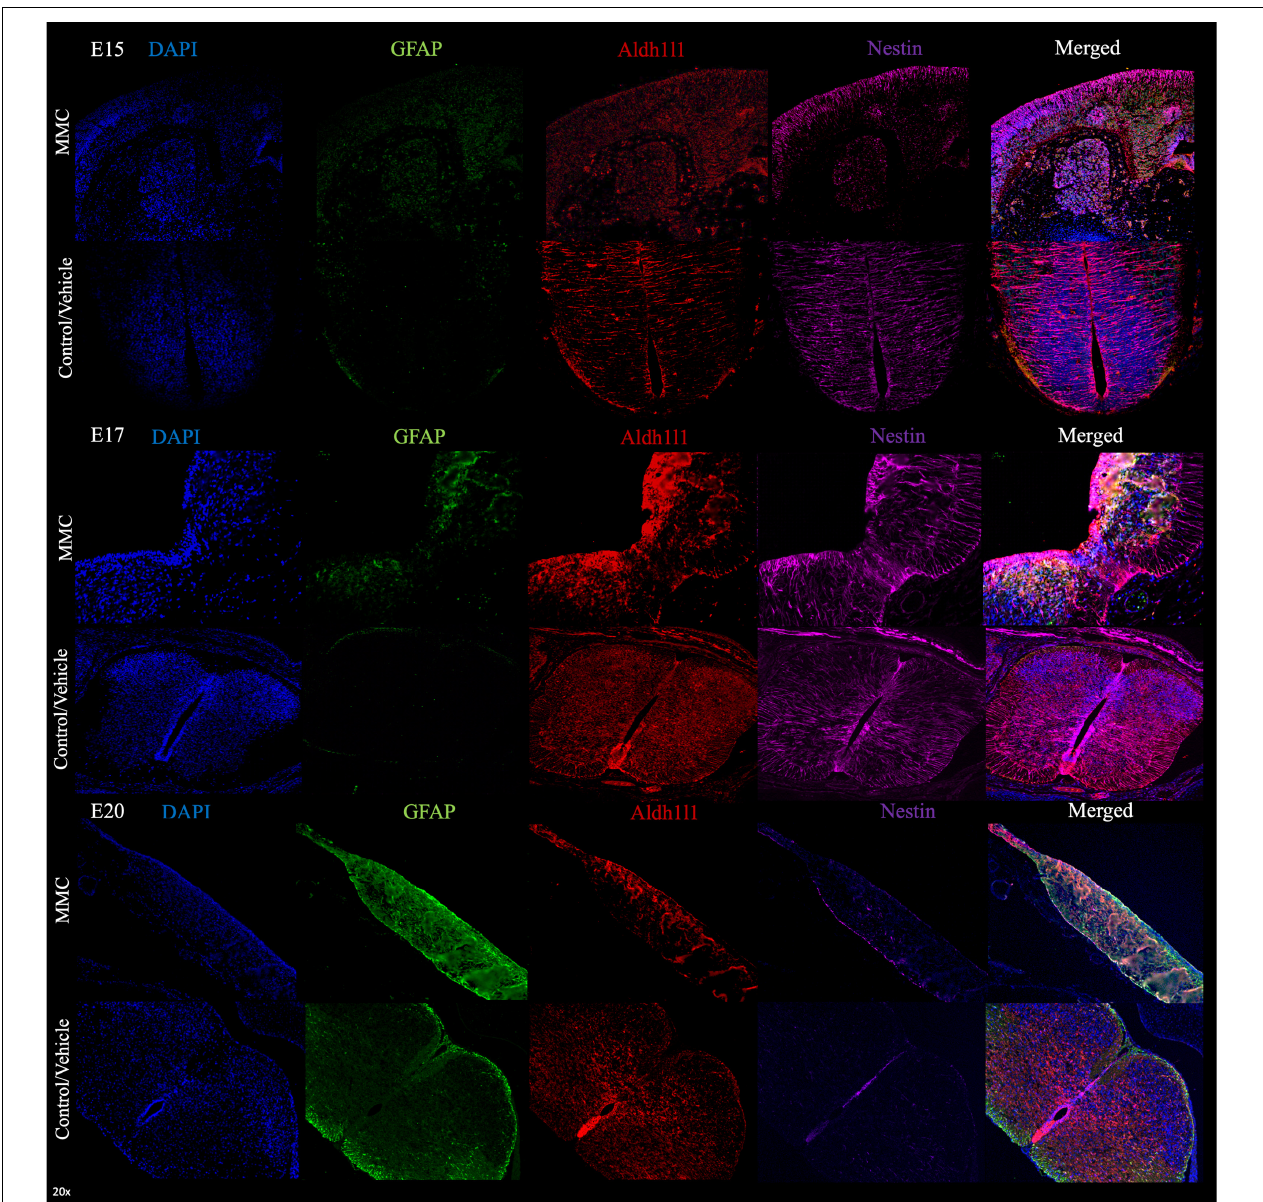
FIGURE 3 | Premature astrocytes in spina bifida. Progressive early astrogliosis in spina bifida (MMC) at E15, E17, and E20 compared with control spinal cords. GFAP (green), Aldh1l1 (red), Nestin (magenta), and DAPI (blue) premature astrocytes localization in VZ exposed to amniotic fluid at E15, E17, and E20 in spina bifida (20 × ).